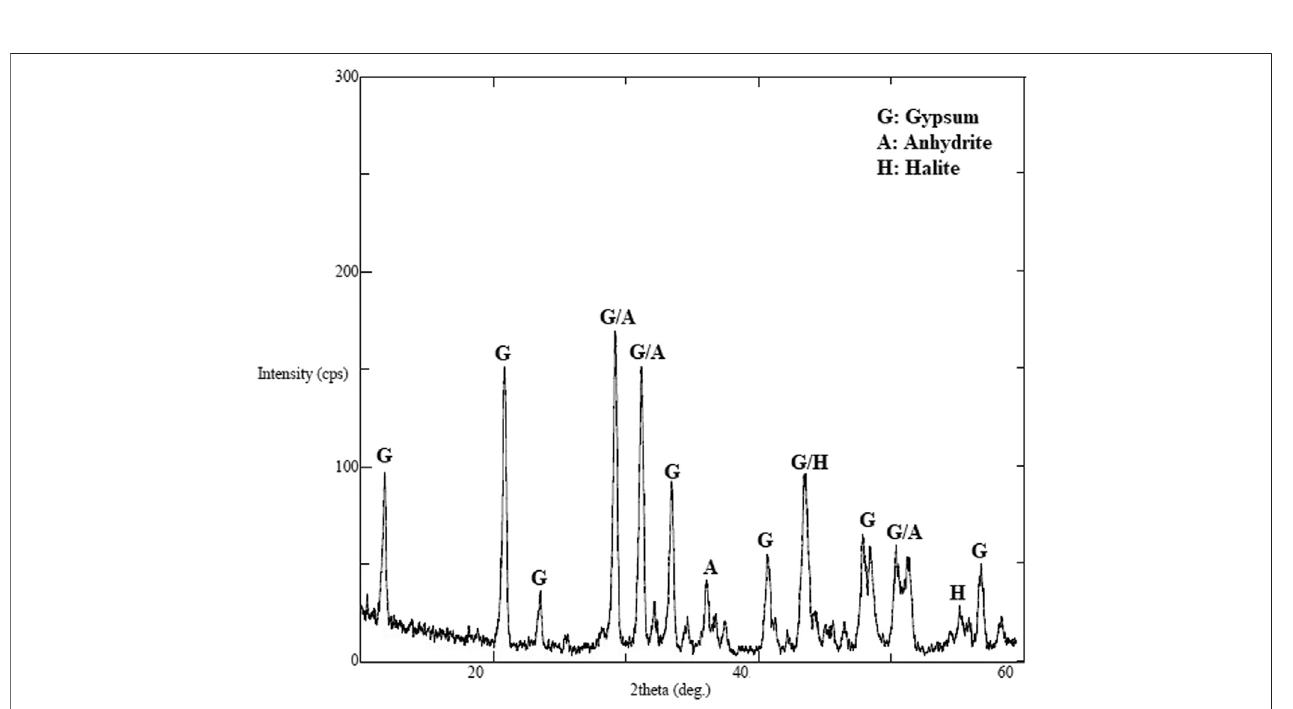
FIGURE 3 | XRD pattern of the salt